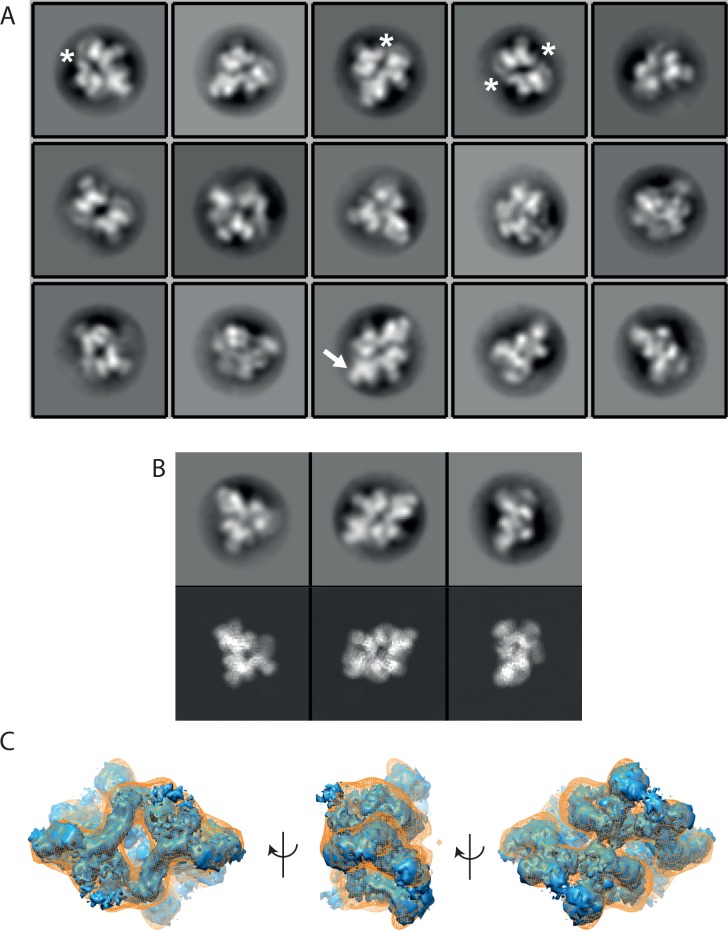
Analysis of negatively stained mTORC2 without applying chemical fixation.(A) Most populated class averages (out of 80 class averages) of a 2D classification of negatively stained non-cross-linked mTORC2. In some class averages a peripheral density (arrow) is underrepresented (star). (B) Comparison of representative class averages (upper panel) with reprojections of the cryo-EM reconstruction with matching projection angles (lower panel). (C) Reconstruction of the non-cross-linked mTORC2 (orange mesh) from negatively stained grids superimposed on a down sampled cryo-EM density of the cross-linked mTORC2.